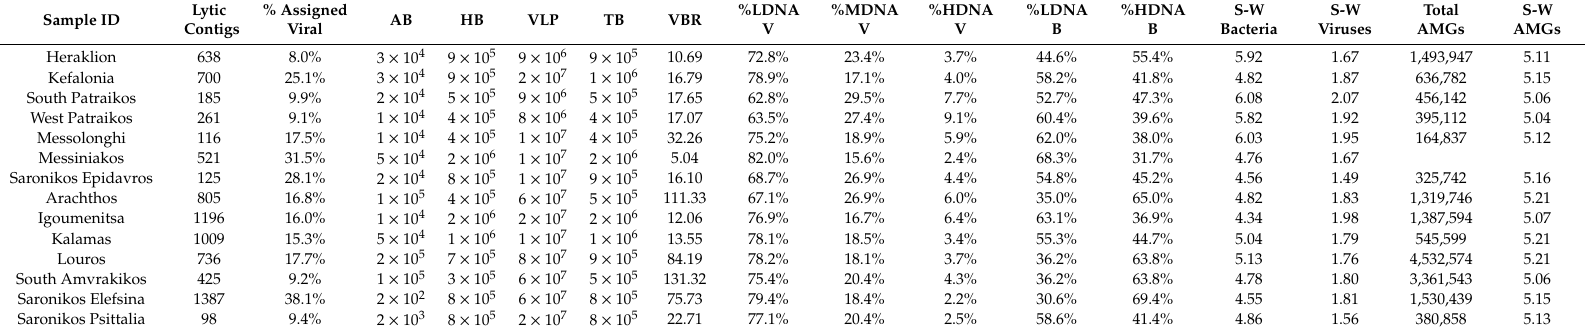
Table 2. Biotic variables. The number of viral lytic contigs detected and the percentage of assigned viral lytic contigs to the taxonomic level of order, family, or genus (% assigned viral lytic). The abundances of autotrophic bacteria (AB, cells mL − 1 ), heterotrophic bacteria (HB, cells mL − 1 ), virus-like particles (VLP, VLPs mL − 1 ) and total bacteria (TB, cells mL − 1 ), the ratio between virus-like particles and total bacteria (VBR), and the percentages of low-, medium-, and high-DNA-content VLPs (%LDNA V, %MDNA V, %HDNA V, respectively) and low- and high-DNA-content HB (%LDNA B and %HDNA B, respectively). Shannon–Wiener diversity indices based on 16S-derived operational taxonomic unit table on the family level (S-W Bacteria) and the viral metagenomic assignment of viral families (S-W Viruses). The total gene copies of AMGs and the Shannon–Wiener diversity index based on AMG content (S-W AMGs). Average and standard deviation (stdev) values are presented based on the two ecological quality